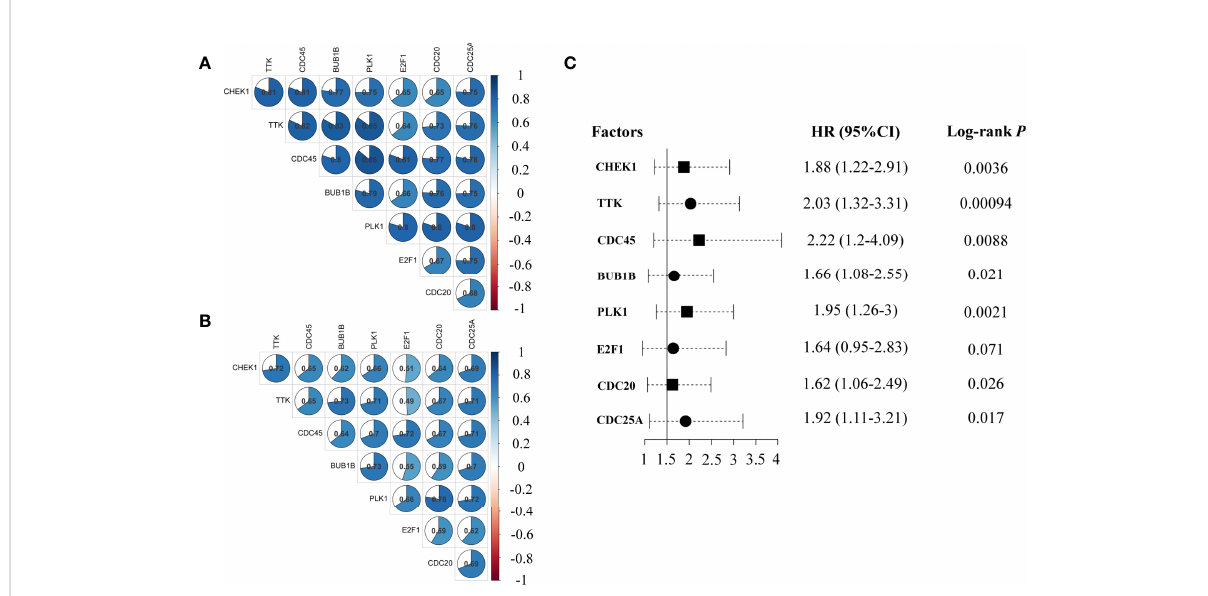
FIGURE 2 Co-expression and HRs of genes in BC-8mriG. The eight MRI-associated genes (BC-8mriG genes) were highly positively correlated in the discovery cohort ( n = 174) and TCGA-BRCA dataset ( n = 1090) (A, B) . Forest plot displays that BC-8mriG genes were all risk factors for BC (C) . HRs, hazard ratios; BC, breast